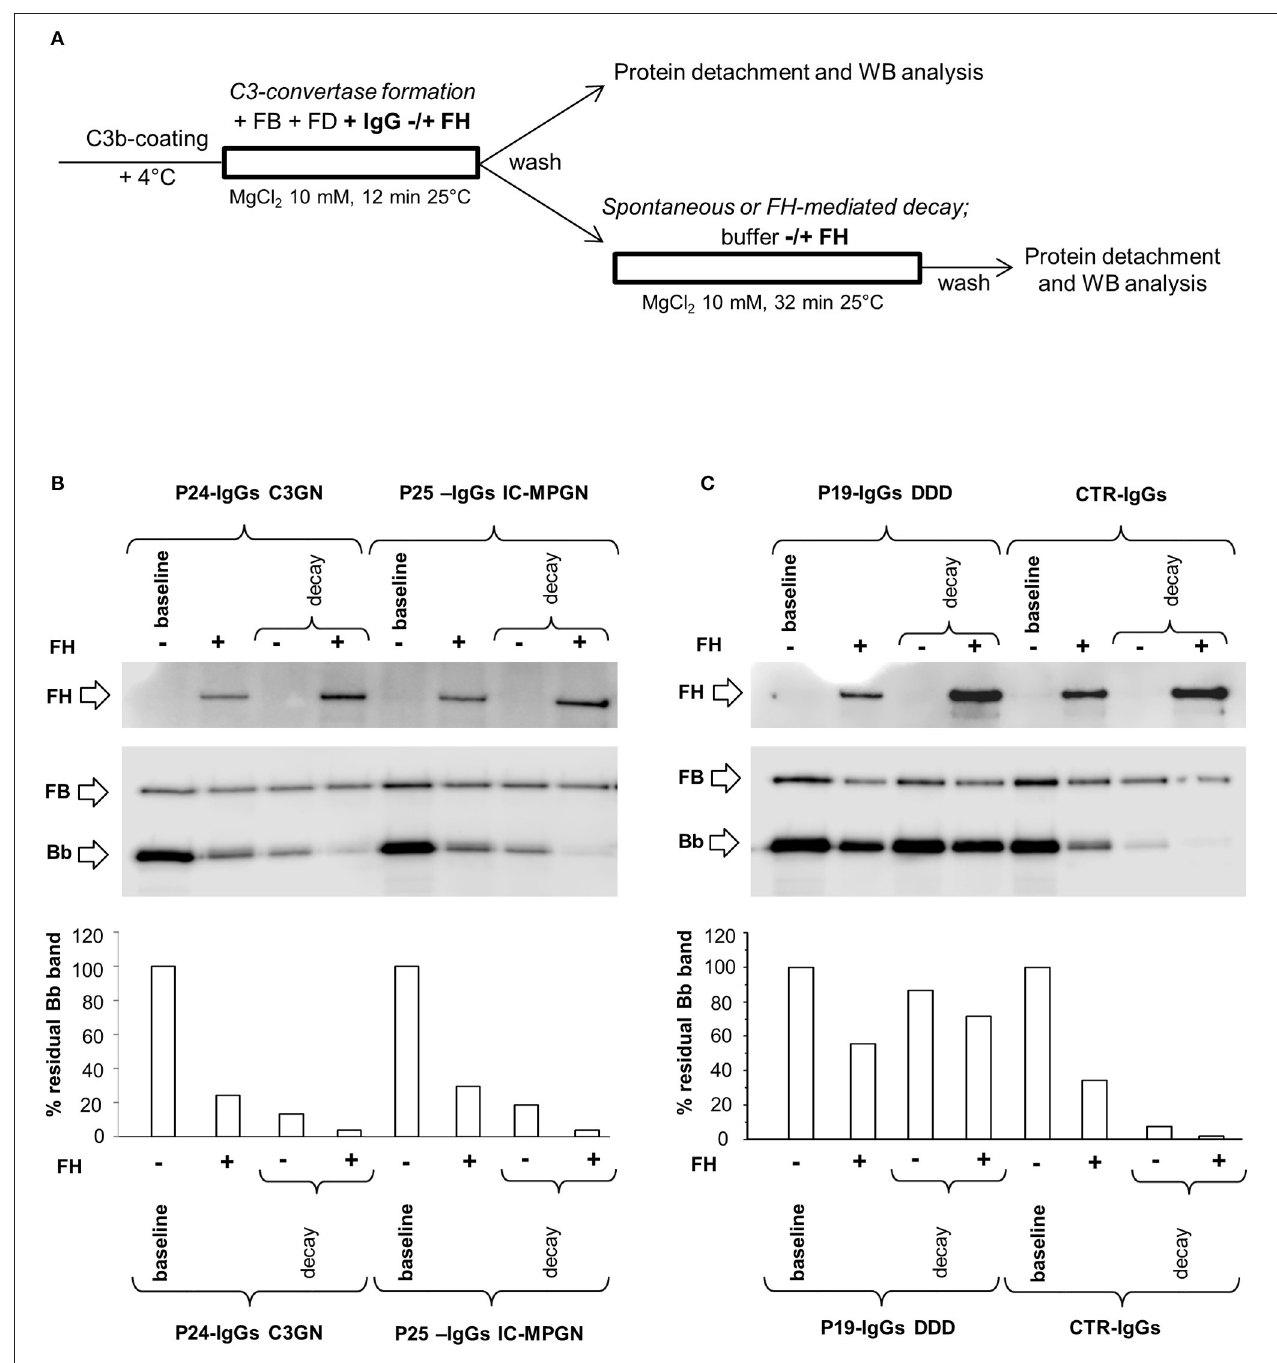
FIGURE 2 | Effect of patient and control IgGs on decay of the C3bBb(Mg 2 + ) C3 convertase by microplate/Western blot (WB) assay. (A) Experimental design (protocol 1) (B-C) Representative images of the assay. C3bBb(Mg 2 + ) complexes were formed by incubating at 25 ◦ C for 12min C3b-coated wells with 1,000ng/ml FB, 10ng/ml FD, 100 µ g/ml IgGs purified from patients or healthy controls and 10mM MgCl 2 in the absence (–, baseline) or in the presence of 2,640ng/ml FH. Spontaneous or FH-mediated decay of the complexes was monitored by further incubation of C3bBb(Mg 2 + ) formed in the absence of FH for 32min at 25 ◦ C with buffer alone (decay –) or 2,640ng/ml FH (decay + ), respectively. The percentage of residual Bb band (visualized by an anti-FB antibody) was calculated as the ratio of the densities (in Pixel 2 ) of each Bb band after decay and the corresponding baseline Bb band density before decay x 100 and results are reported in the bottom graphs. The membranes were then incubated with an anti-FH antibody and FH band could be visualized at 150 KDa (top). Results of a representative microplate/WB experiment of n = 3 for each sample are shown.